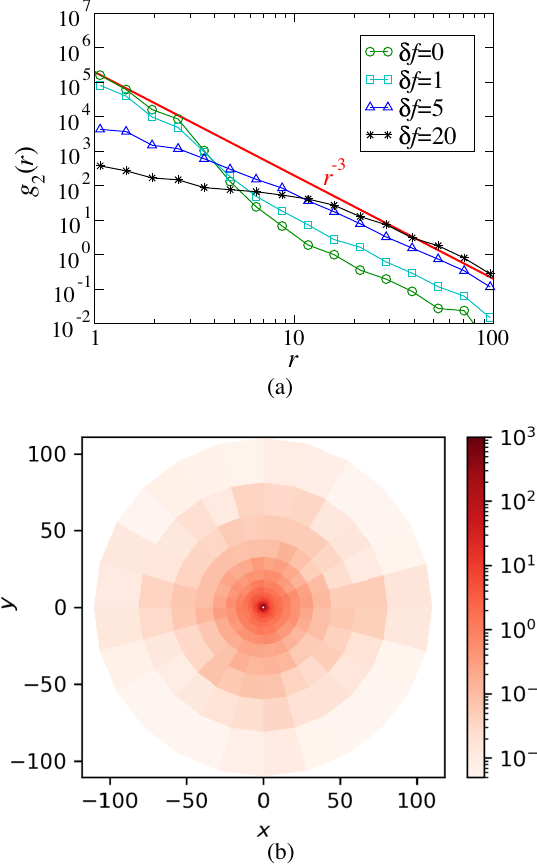
FIG. 4. (a) The time-dependent pair correlation function of rearrangers g 2 ð r; δ f Þ for different numbers of frames δ f follow- ing the rearrangement at the origin at frame f ¼ 0 . (b) The time- averaged directional plot g 2 ð r Þ ¼ ð 1 =F Þ F ¼ 20 .